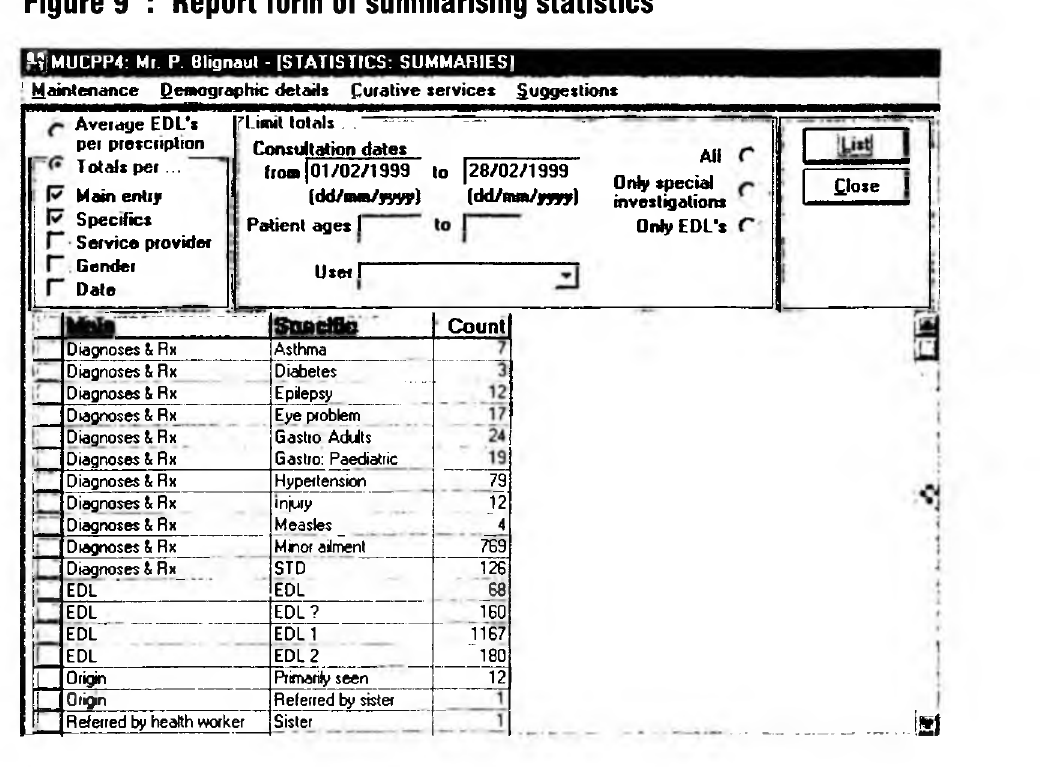
Figure 9 : Report form of summarising statistics